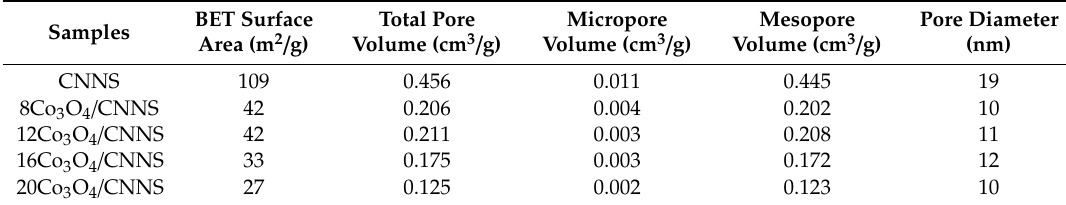
Table 1. Textural property and average pore diameter of the pure and Co 3 O 4 -modified CNNS.